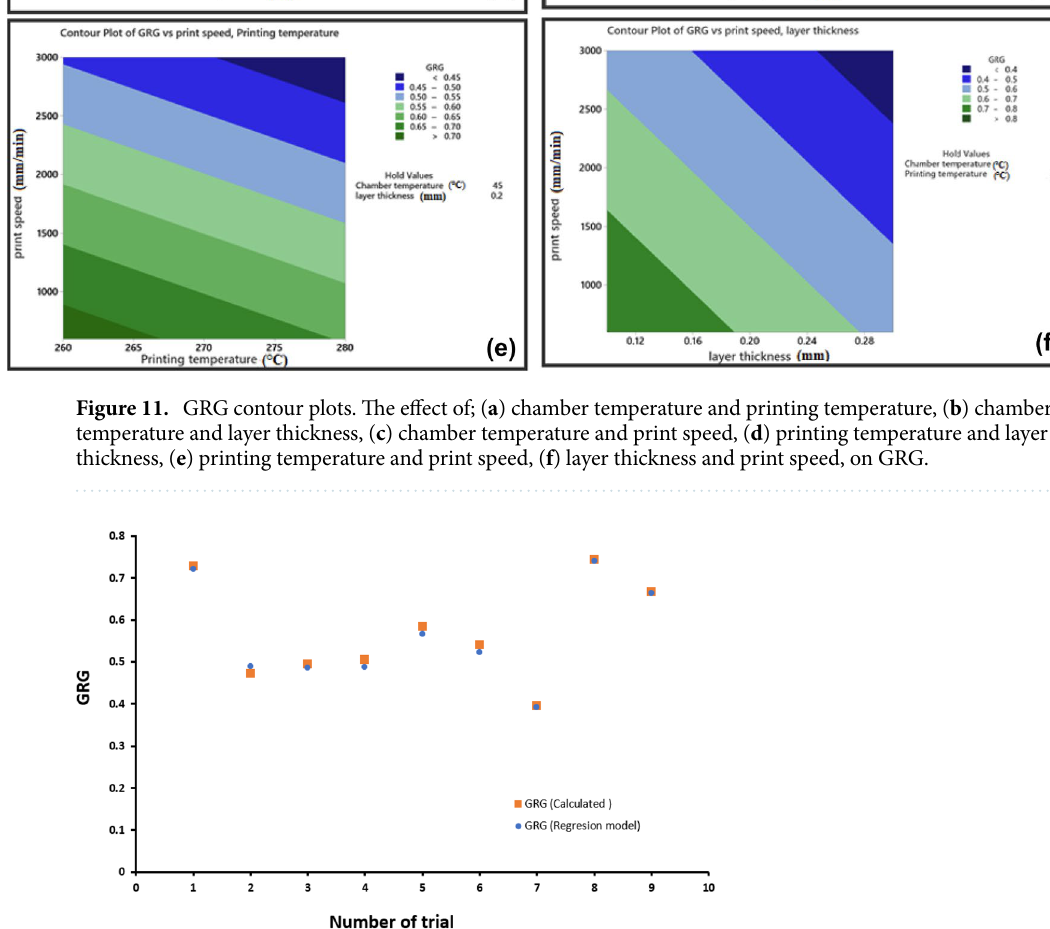
Figure 12. Comparison of GRG values obtained from regression model and obtained from